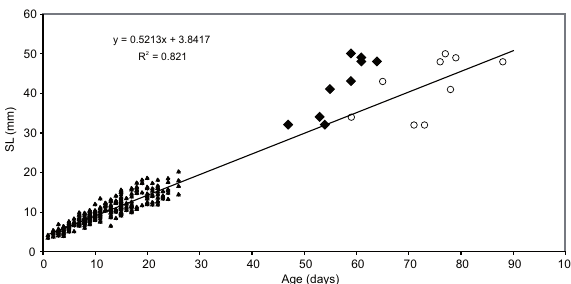
Fig . 6. – Comparison between the linear model of larval growth (solid line) and the length at age of juveniles obtained from postros- trum readings of age based on the IMR method (white circles) and the GBR method (black diamonds). Solid black circles correspond to larval age